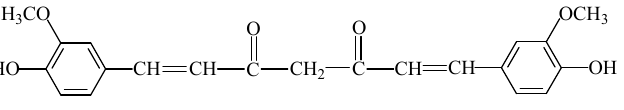
Figure 1. Structural formula of curcumin (E100).